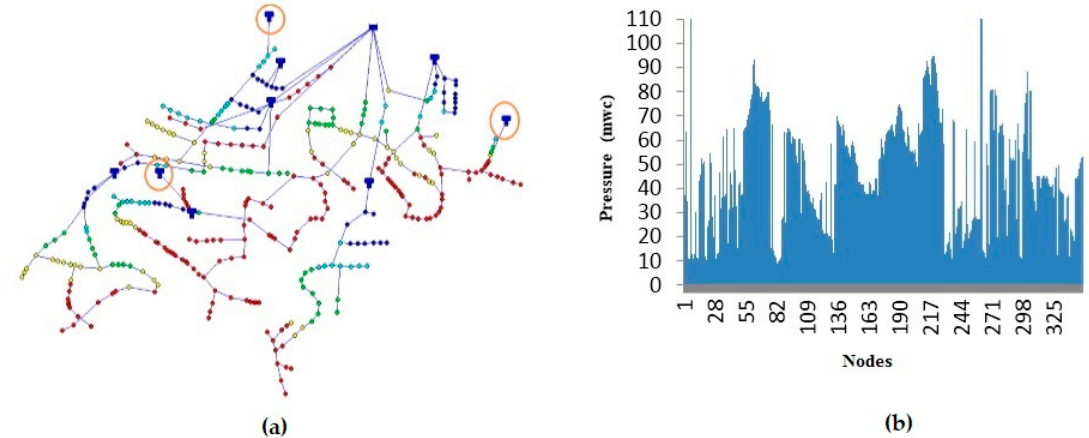
Figure 3. Pressures for each node after adding new tanks (unfeasible solution). ( a ) New storage tanks added ( b ) Pressure distribution.